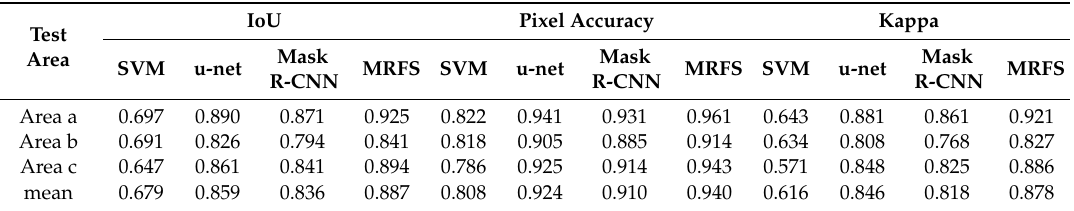
Table 1. Quantitative evaluation of di ff erent methods on building extraction.